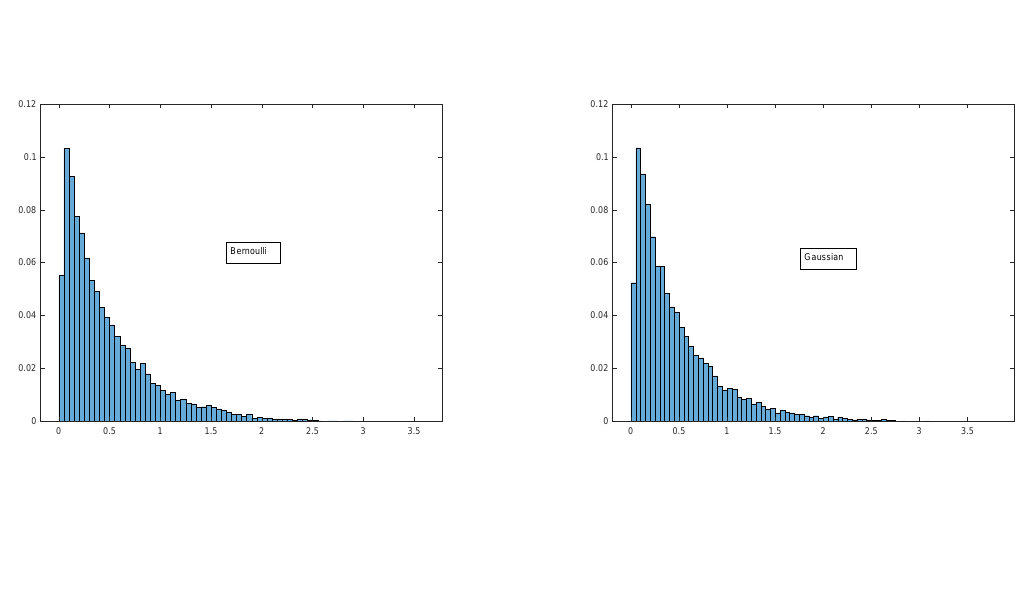
Figure 1: Histogram of the minimum modulus over 10 4 points equally spaced points on the unit circle, for 10 4 samples of a random degree 20 polynomial P n ( x ) of (1.4) with Rademacher (left) and Gaussian (right)